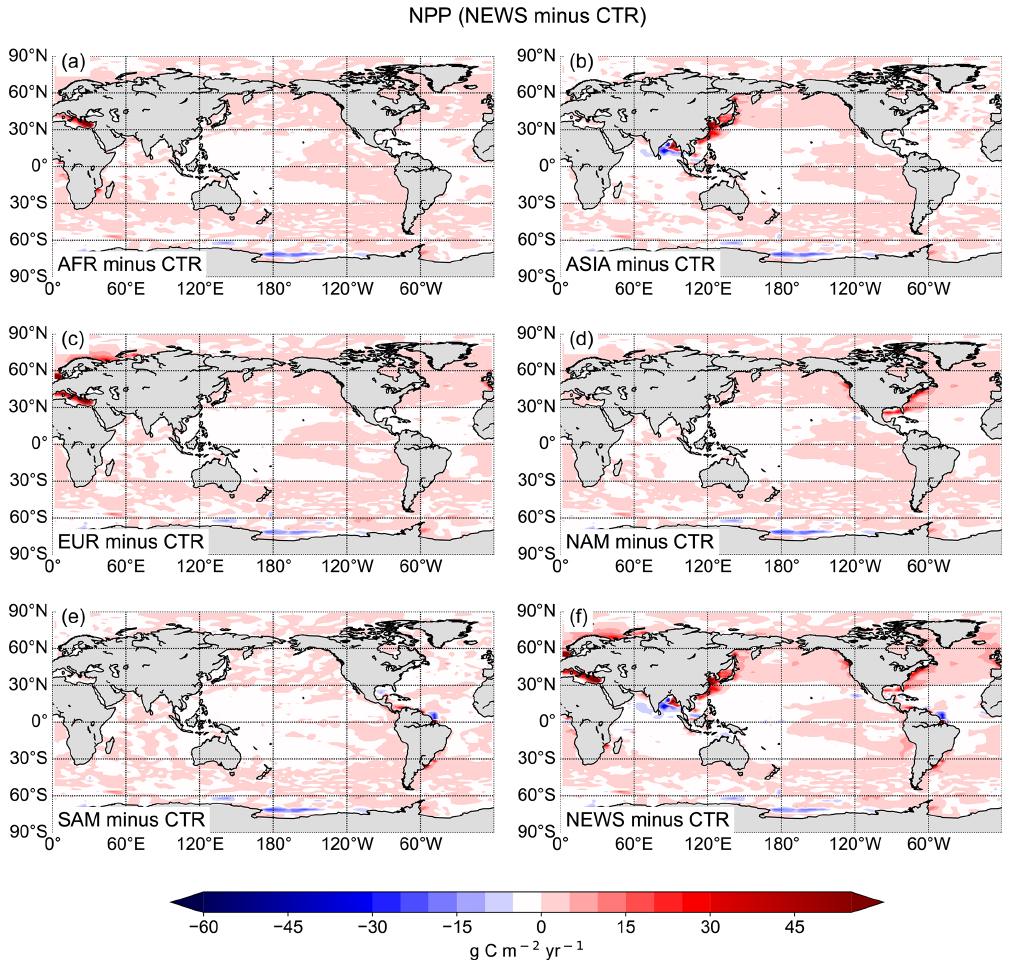
Figure 14. Difference in the global vertically integrated rates of primary production (NPP) between regional NEWS and the control simula- tion (CTR). The regional simulations show export from rivers in Africa (a) , Asia (b) , Europe and Russia (c) , North America (d) , and South America (e)